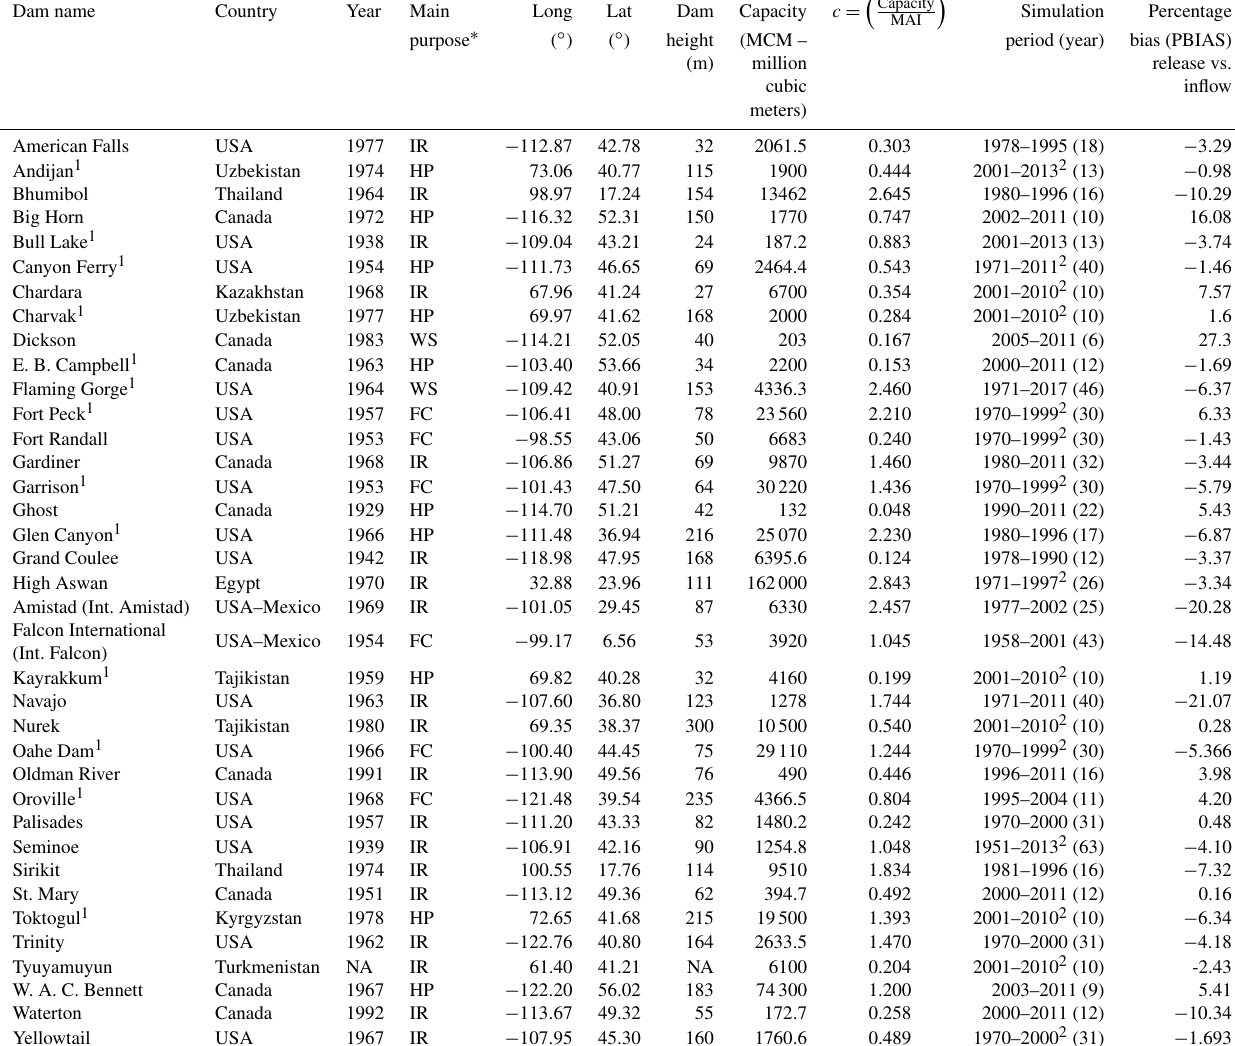
Table 1. Summary of